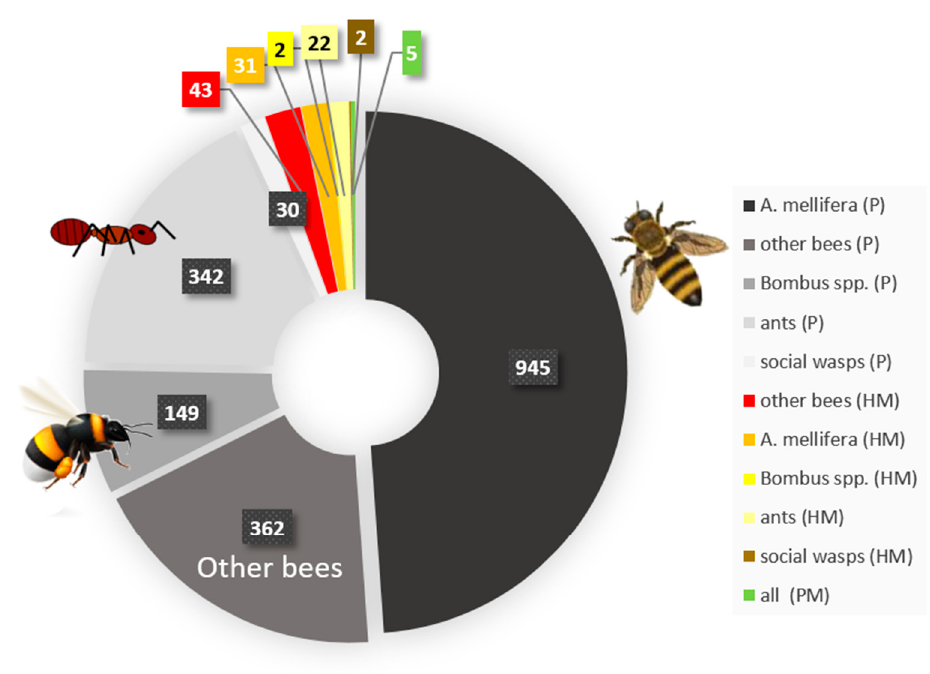
Figure 2. The proportion of publications that studied the di ff erent types of pollutants in relation to the di ff erent groups of social Hymenoptera on ISI Web of Science. Most studies investigated the e ff ects of pesticides (P) on social Hymenoptera (n = 1828 in total; shaded in grey). Studies reporting the occurrence of pesticides in individuals, their food, or the nest were also included. Almost 75% of the studies were conducted on bees, most likely due to their importance as pollinators. Studies on ants in relation to pesticides show a rather narrow focus on the eradication of invasive species using insecticides. In total, only 98 studies elucidated the impact of heavy metals (HM) or the heavy metal content of bee products or nest material of social insects. Even fewer studies (n = 5) exist on the presence of particulate matter (PM) on the cuticle or its potential impact on any social Hymenoptera species. Search terms were either “Apis”, “Bombus”, “bumblebee”, “bee”, “ant”, or “wasp” for the group of social Hymenoptera with “health”, “toxic*”, or “e ff ect“ as a keyword for the impact of the pollutants, and either “pesticide*”, “fungicide*”, “insecticide*”, “heavy metal”, “particulate matter” or “air pollution” as search terms for fine particulate matter. The first (newest) 50 publications per search were screened for the proportion of publications that did not fit thematically, and this percentage was subtracted from the original number of publications returned by the search.